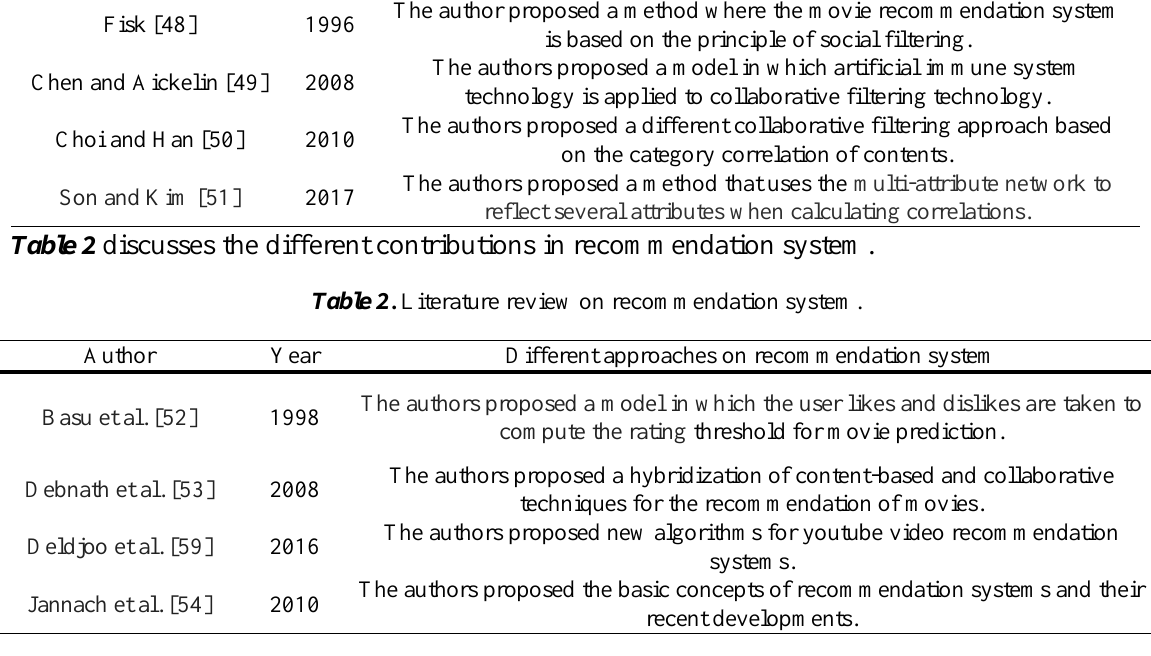
Table 3 discusses the different contributions in collaborative and content based approach. Table 3. Literature review on collaborative and content based system.